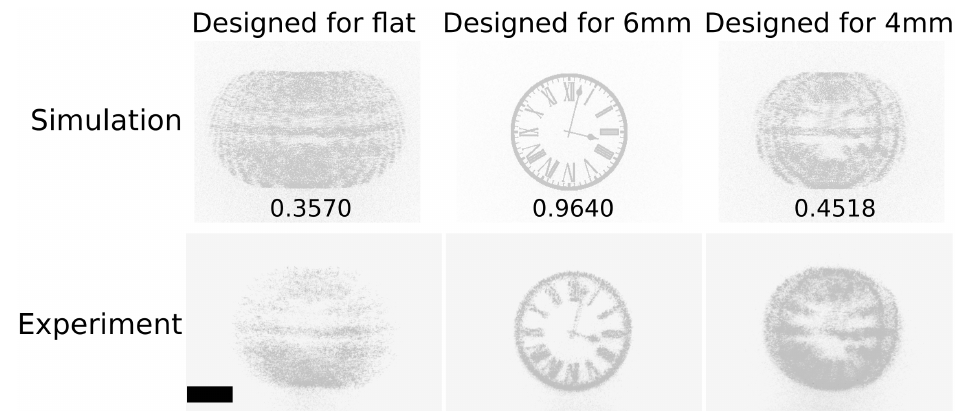
Figure 4. Simulated and experimental holographic image results, comparing MS designed for various convex cylinders with differing radii of curvature. In each case, the MS was analyzed as being applied to a convex cylinder with a radius of curvature of 6 mm and λ = 630 nm. For the experimental results, the scale bar represents 10 mm. The numbers correspond to the correlation coefficient, where 1 is perfect